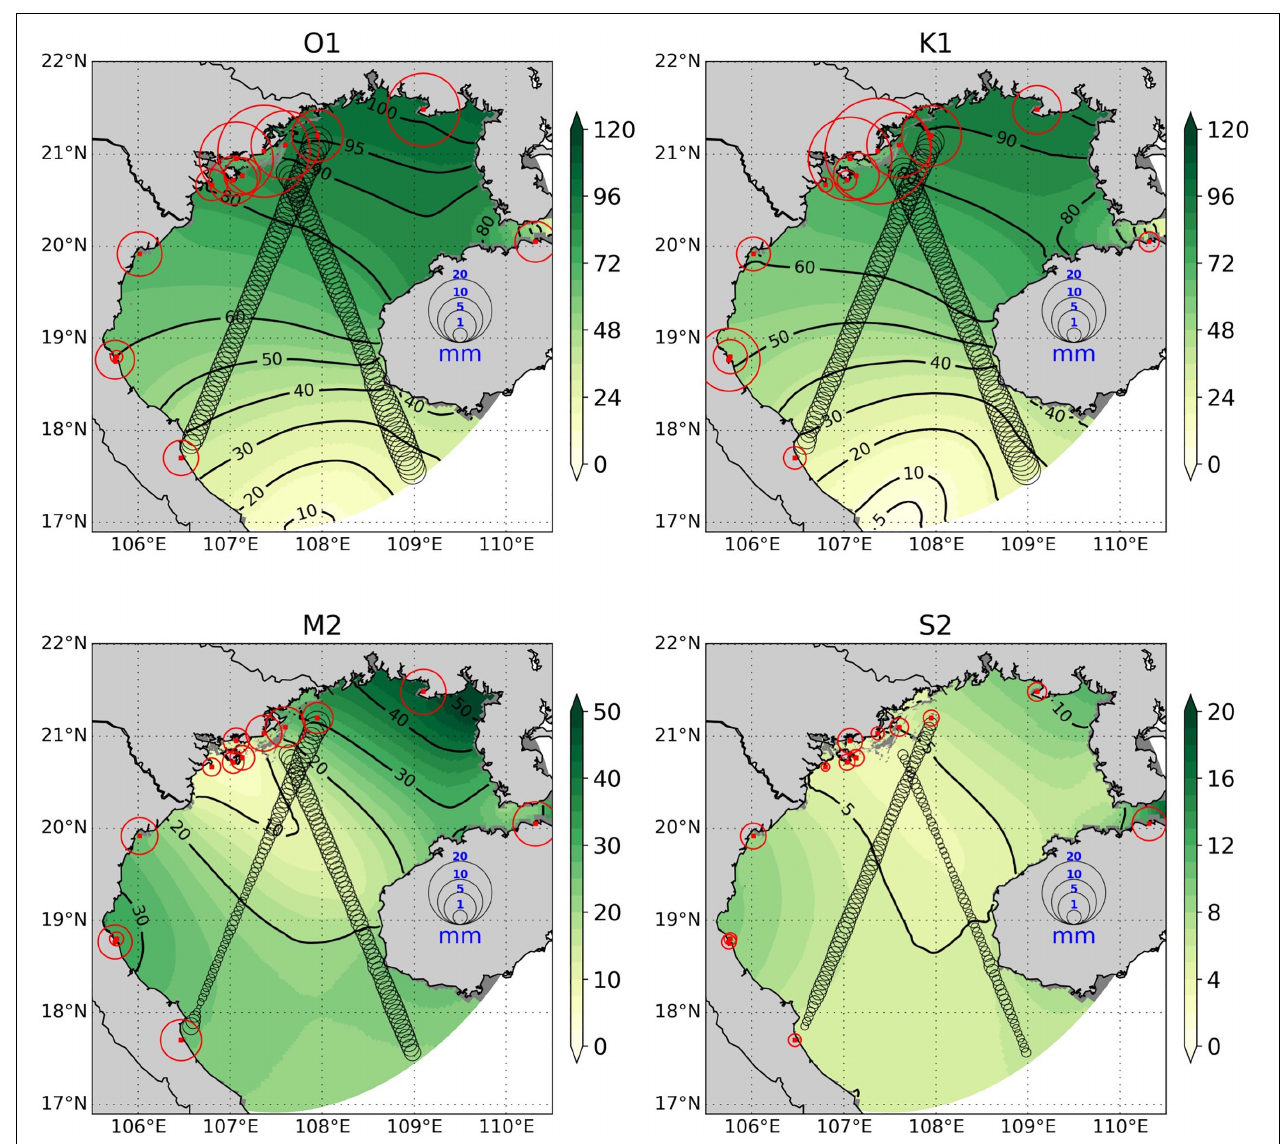
FIGURE 3 | Amplitude of the tidal constituent (in colors, cm) from GOT_REF. Each figure shows the complex error (mm), calculated from the amplitude and phase, between model result and observational data for 4 main tidal constituents (O1, K1, M2, S2). Black circles show errors compared to altimetry data, while red circles indicate errors compared to the tidal gauges